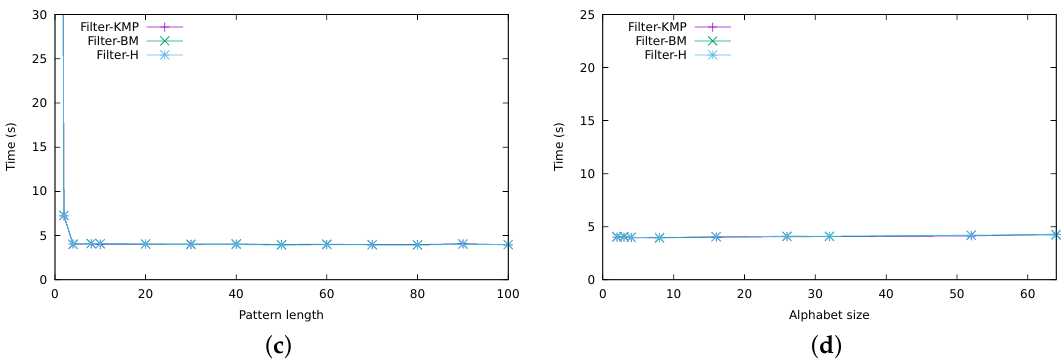
Figure 6. Running time of the filtering algorithms (Knuth–Morris–Pratt (Filter-KMP), Boyer–Moore (Filter-BM), and Horspool (Filter-H)) for permuted pattern matching with respect to ( a ) the text length, ( b ) the track count, ( c ) the pattern length, and ( d ) the alphabet size.